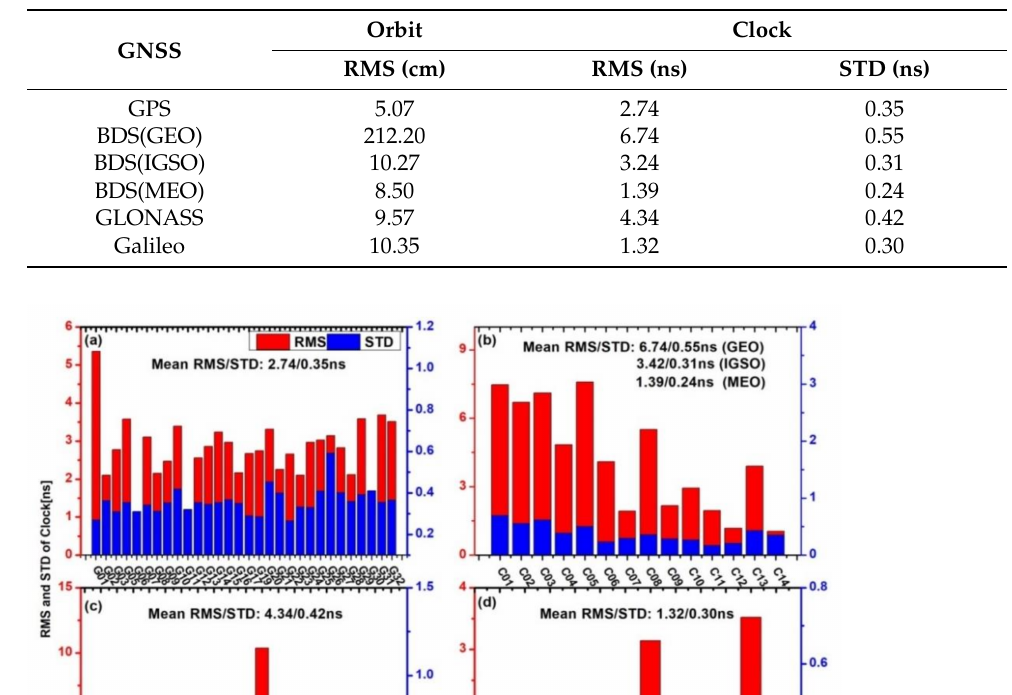
Figure 3. Average RMS of orbits in three directions, calculated for real-time multi-GNSS compared to GFZ’s final products: ( a ) GPS; ( b ) BDS; ( c ) GLONASS; ( d ) GALILEO. Table 2. Mean values of RMS and STD of orbit and clock determination.